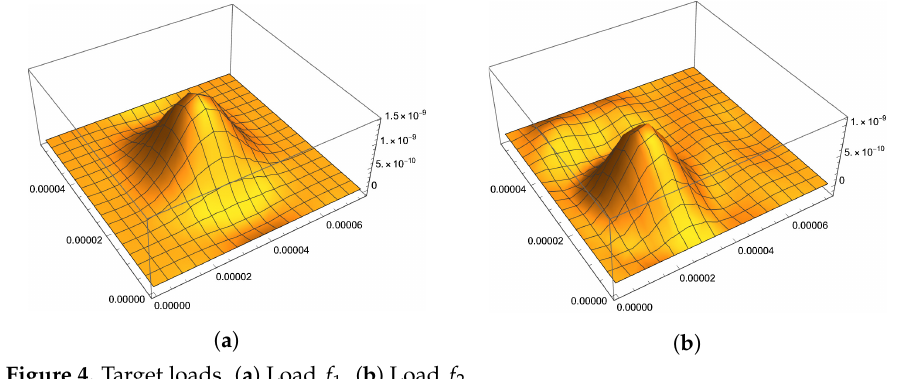
Figure 4. Target loads. ( a ) Load f 1 . ( b ) Load f 2